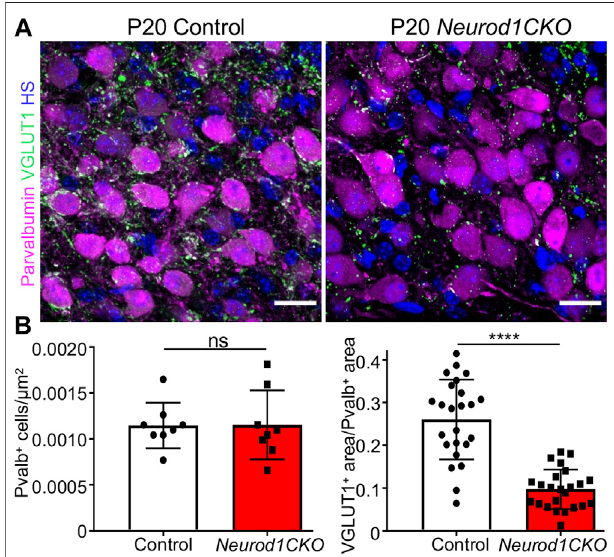
FIGURE 7 | Auditory afferent synapses are reduced in the anteroventral cochlear nucleus of Neurod1CKO adult mice. (A) Representative confocal images of anti-parvalbumin labeled spherical bushy cells and anti-VGLUT1 labeled auditory-nerve endings, endbulbs of Held, show a loss of auditoryafferentsynapses in Neurod1CKO thatwrap thesomaofbushycells. (B) Quanti fi cation of spherical bushy cells ( n = 4 mice/two sections/genotype) and VGLUT1 + synapses per the parvalbumin + area ( n = 4 mice/two sections/ three cells per section/genotype). The values represent means ± SD, t- test; ns, not signi fi cant; **** p ≤ 0.0001. Scale bars: 20 µm. HS, Hoechst nuclear